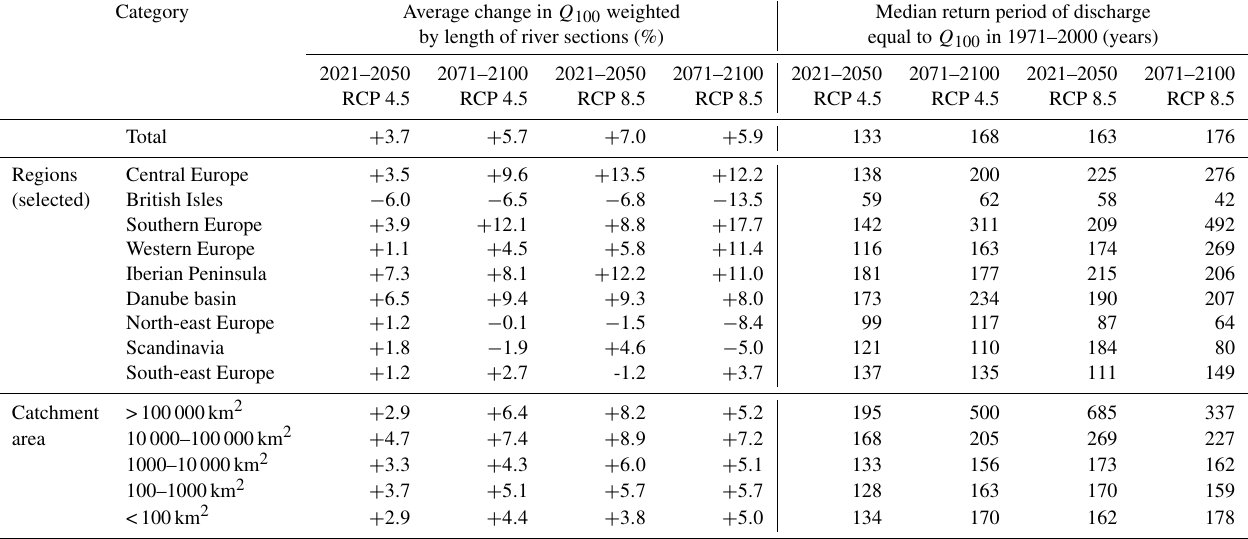
Table 3. Projected change in 100-year river discharge ( Q 100 ) relative to 1971–2000, and return periods of discharge equal to Q 100 in 1971–2000 for two emission scenarios RCP 4.5 and RCP 8.5. Predictions based on EC-EARTH-COSMO_4.8_clm17 climate model run.